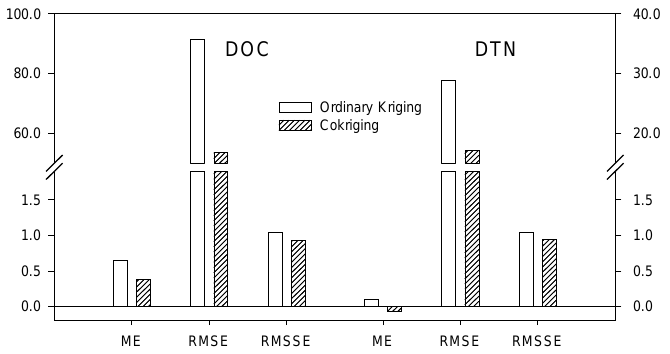
Figure A4. Mean error (ME), root mean square error (RMSE), and root mean square standardized error (RMSSE) values of ordinary kriging and cokriging for DOC and